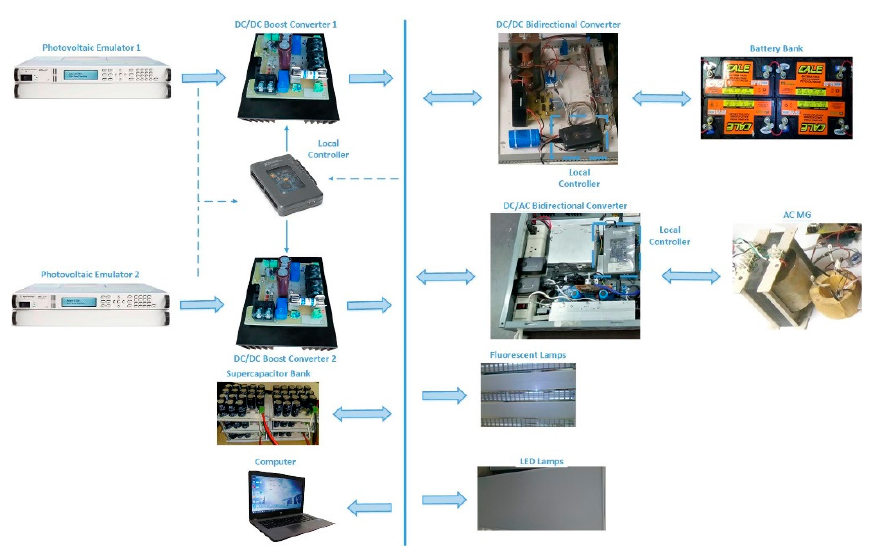
Figure 2. DC-µG experimental test-bed.